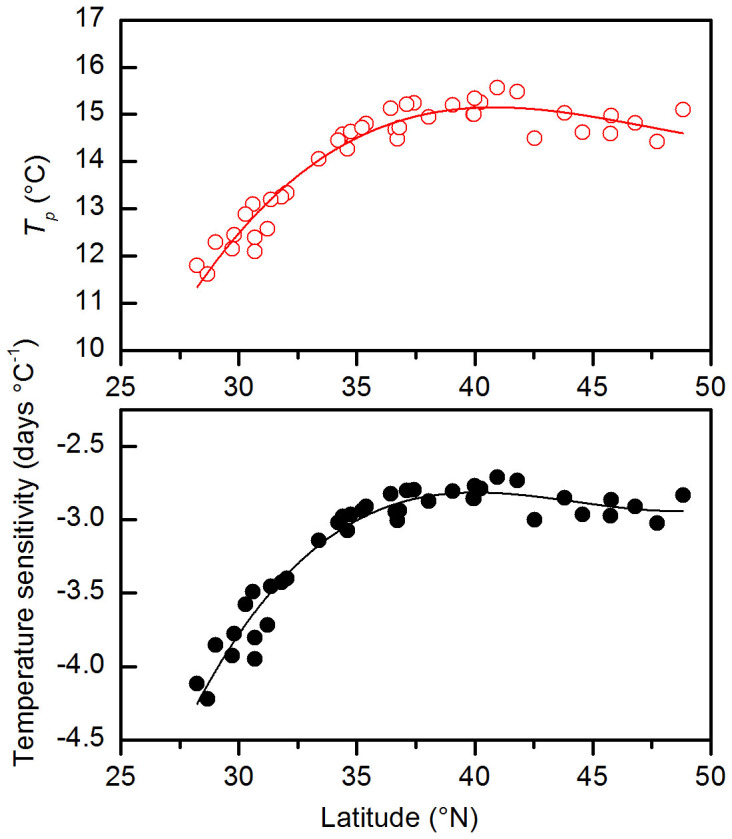
The temperature at the onset date of phenophase (Tp) and temperature sensitivity (Tsen) for first leaf date of Sophora japonica plotted according to latitude.The overall dependence of Tp and Tsen on latitude is high: for Tp: R2 = 0.93, y = −59.98 + 4.922*x − 0.1059x2 + 7.452*10−4x3, n = 41, P < 0.001; for Tsen: R2 = 0.94, y = −38.37 + 2.450*x − 0.059x2 + 4.204*10−4x3, n = 41, P < 0.001.